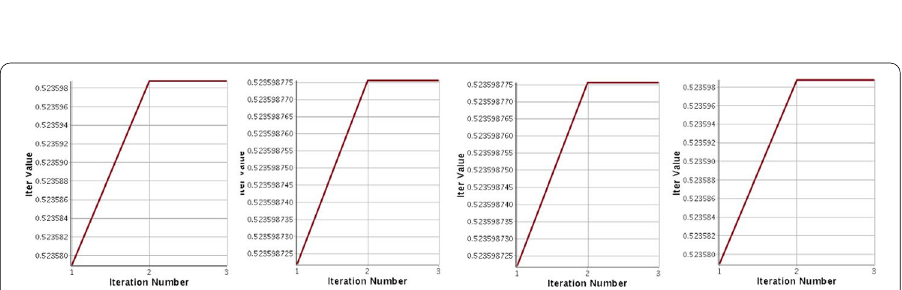
Fig. 2 Iteration values at different iteration numbers for 8th BM at different θ ( θ = − 1, − 0.5,0.5,1 ) respectively for g 2 ( x )